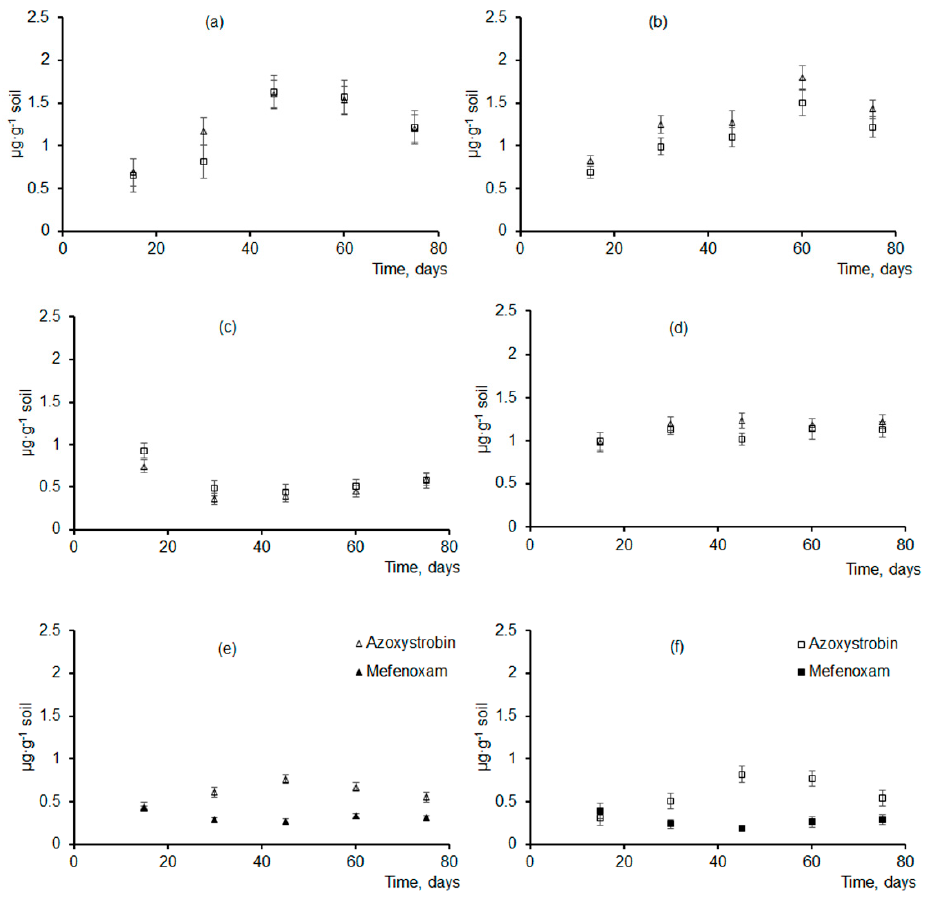
Figure 9. Current soil concentrations of fungicides ( µ g · g − 1 ) released from experimental granules of different sizes: triangles—smaller granules (1.5 mm diameter); squares—larger granules (3.0 mm diameter). ( a )—P(3HB)/wood flour/azoxystrobin, ( b )—P(3HB)/wood flour/difenoconazole, ( c )— P(3HB)/wood flour/mefenoxam, ( d )—P(3HB)/wood flour/prothioconazole, ( e )—P(3HB)/wood flour/azoxystrobin + mefenoxam (smaller granules), ( f )—P(3HB)/wood flour/azoxystrobin + mefenoxam (larger granules).